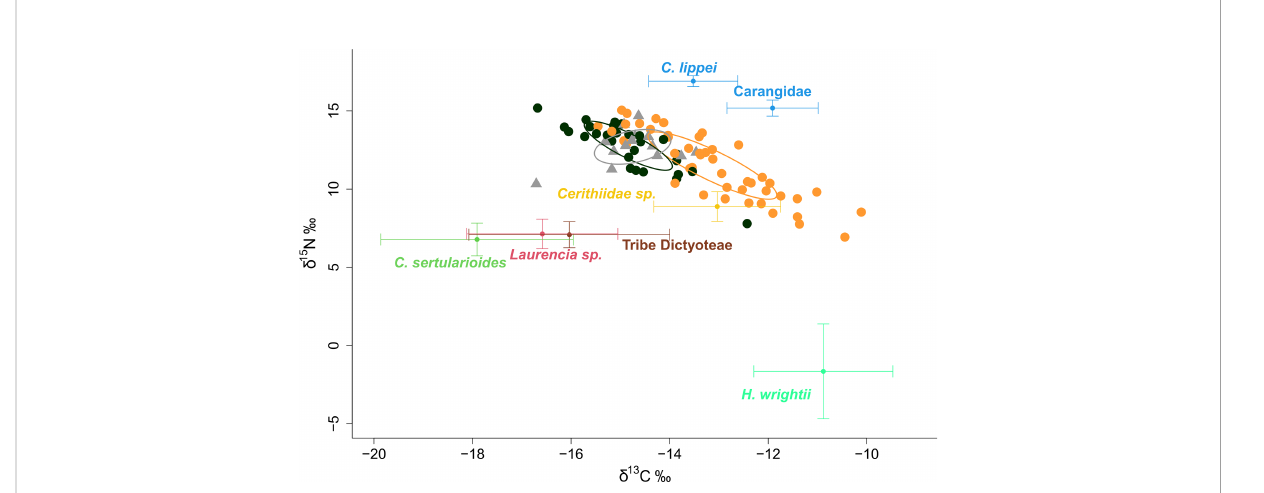
FIGURE 5 Isospace plot of green turtle isotopic signatures (points), macrophytes (red algae: Laurencia sp.; brown algae, Tribe Dictyoteae; green algae, Caulerpa sertularioides ; seagrass, Halodule wrightii ), and additional animal samples (benthic gastropod: Cerithiidae sp. ; invertebrate specialist fi sh, Chaetodipterus lippei; active predatory fi sh, Carangidae) from Unhocomo and Unhocomozinho foraging grounds. Turtle symbols indicate life-stage – triangles, recruits; circles, established turtles – and colors indicate habitat of capture - black – rocky-bottom, orange – sandy- bottom. Ellipses represent the standard ellipse area corrected (SEAc) produced by SIBER, also color-coded by